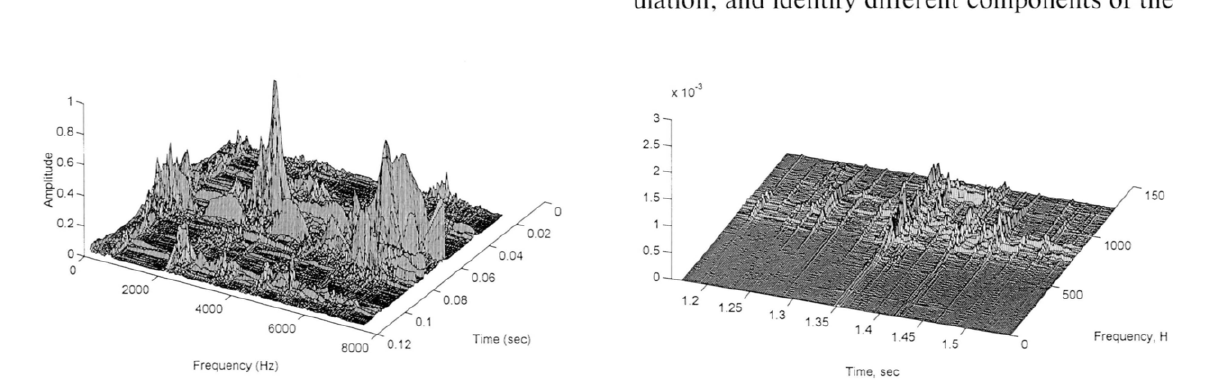
FIGURE 10 Mesh plot of CWD of crane gearbox signal shown in Fig.